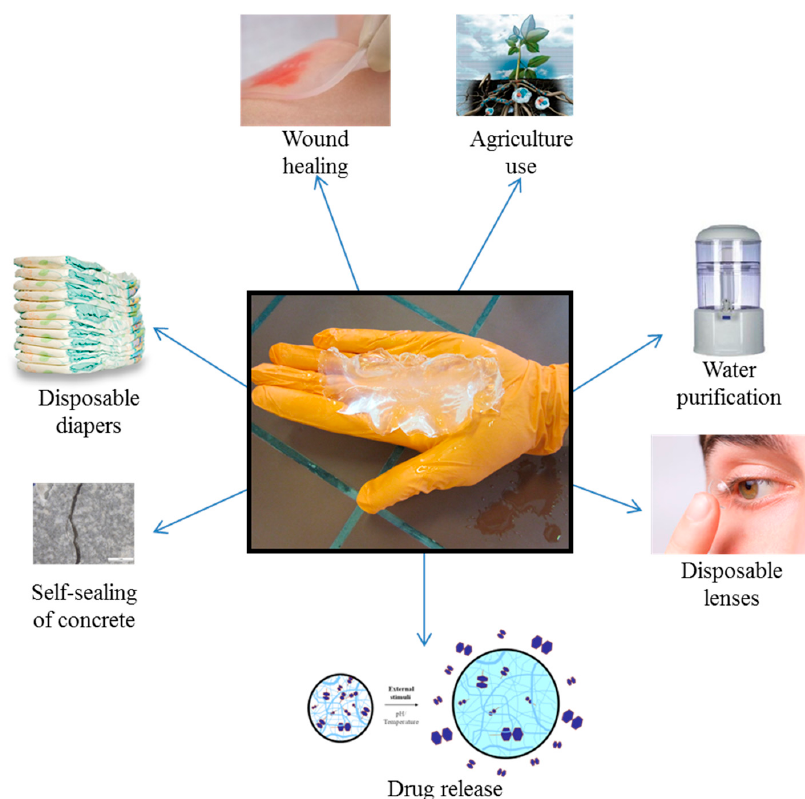
Figure 2. Overview of different applications of SAPs including diapers, biomedical (e.g., wound healing. Adapted from [57], with permission from © 2014 Kikgel), drug release [58] (World’s largest Science, Technology & Medicine Open Access) and disposable lenses, agriculture (Adapted from [59], with permission from © 2014 Terracottem), water purification and self-sealing and -healing of concrete.